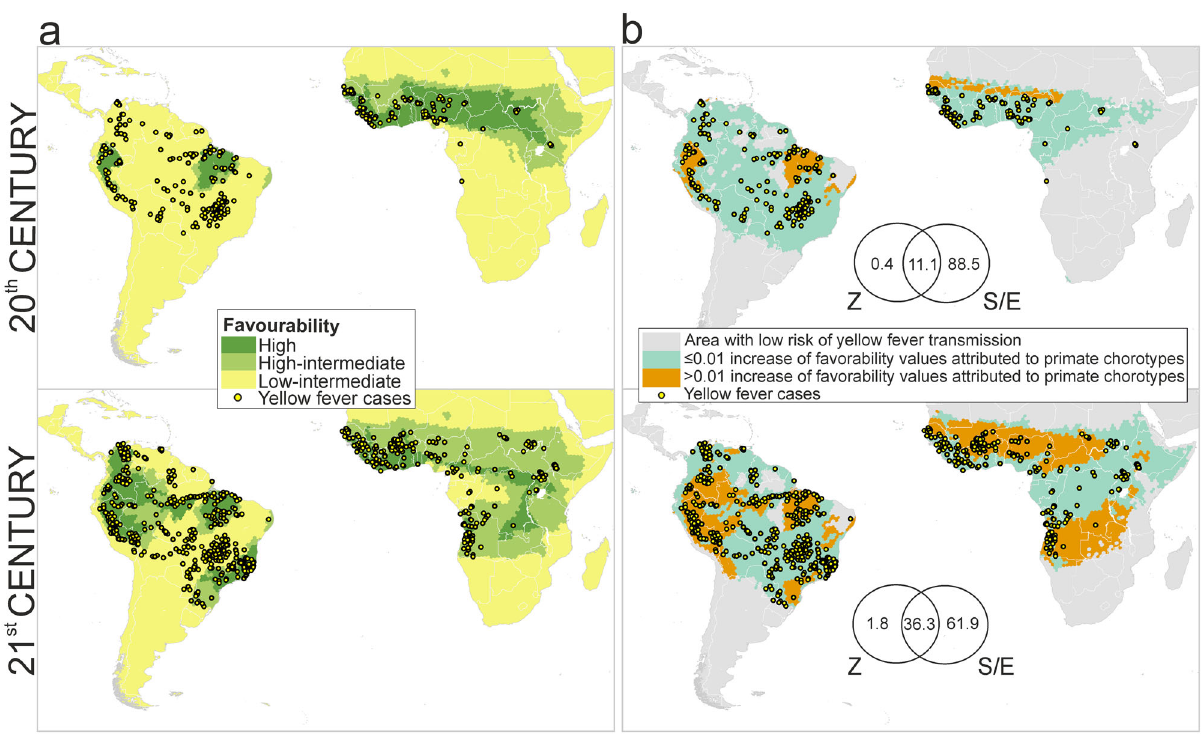
Fig. 2 Contribution of the zoogeographic factor. a Model of favourability for the occurrence of yellow fever cases according to the presence of non-human primate chorotypes (i.e., zoogeographic model) [the scale for favourability values is: high ( F > 0.8); high-intermediate (0.5 ≤ F ≤ 0.8); low-intermediate (0.2 ≤ F < 0.5)]. b Partial contribution of primates on the presence of yellow fever cases in humans [the numbers are percentages of contribution to the distribution of favourability in the disease models (Z: zoogeographic factor, S/E: spatial/environmental factor)]. The maps in a represent the areas where the primate presence could favour the occurrence of disease cases in humans, although correlations with other factors in fl uencing the primate biogeography (such as climate, topography or land cover) might be involved in this relation. Instead, the maps in b highlight the areas where the presence of primates could favour the occurrence of yellow fever regardless of correlations with other